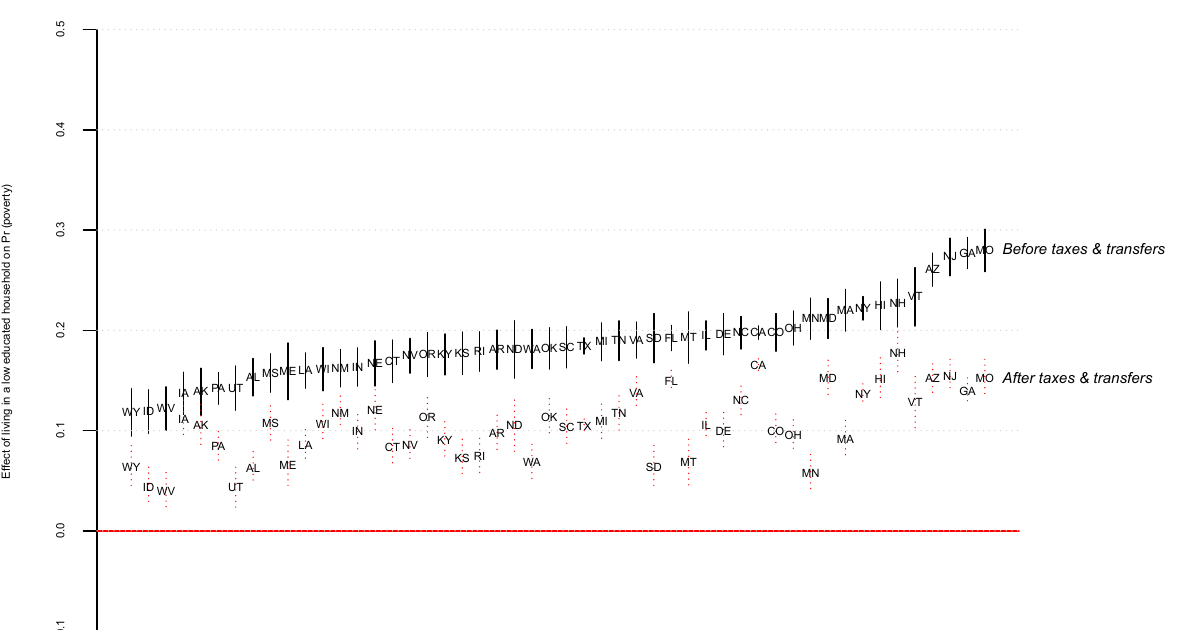
Figure 5: Low education penalty: effects of living with a less educated head on Pr (poverty) before and after taxes and transfers (2012–2016 CPS). Adjustments for SNAP, SSI, and TANF underreporting were made using the Urban Institute Transfer Income Model (TRIM). Effects represent coefficients from varying slope linear probability models predicting SPM poverty. The nonvarying slopes in the model are year fixed effects and a control for metropolitan and/or nonmetropolitan status. States are indicated by their postal code